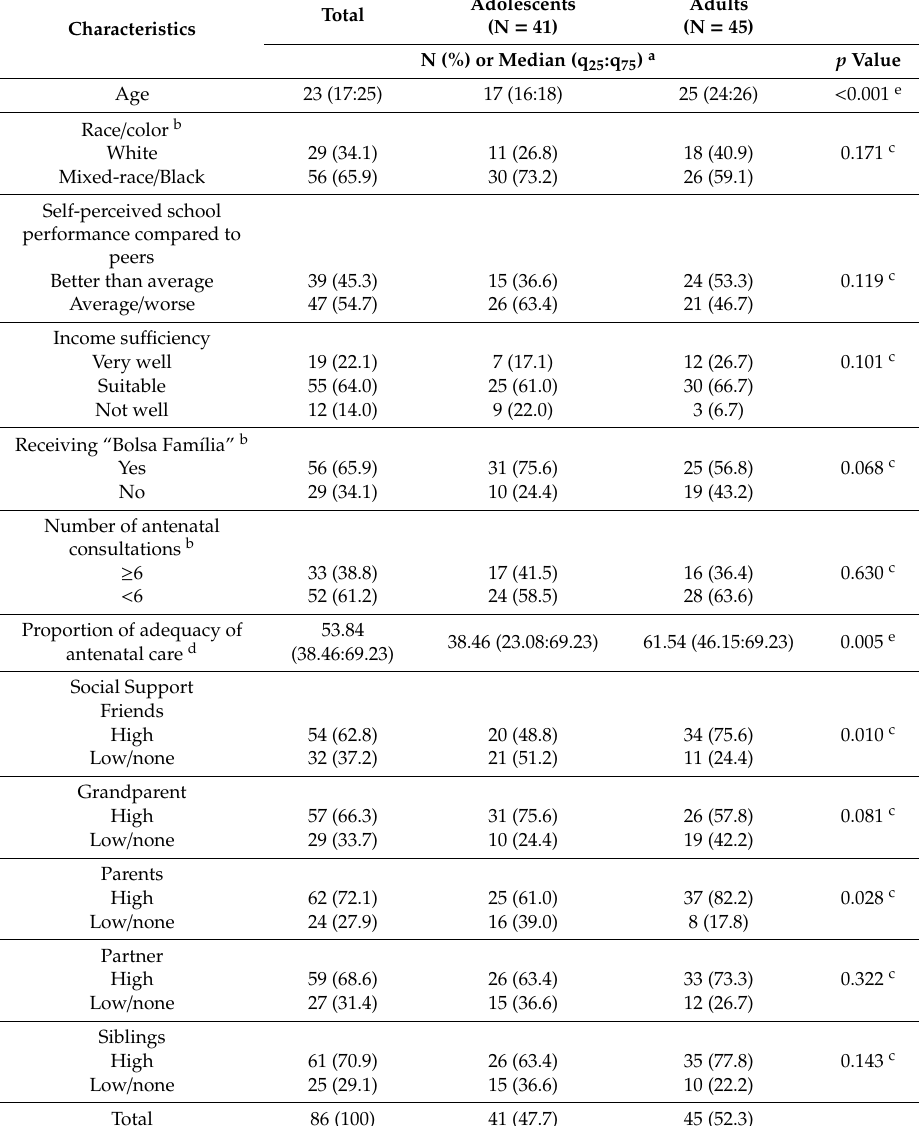
Table 1. Sample characteristics according to age groups, Trairi region, Rio Grande do Norte, Brazil, 2017–2018 (N =